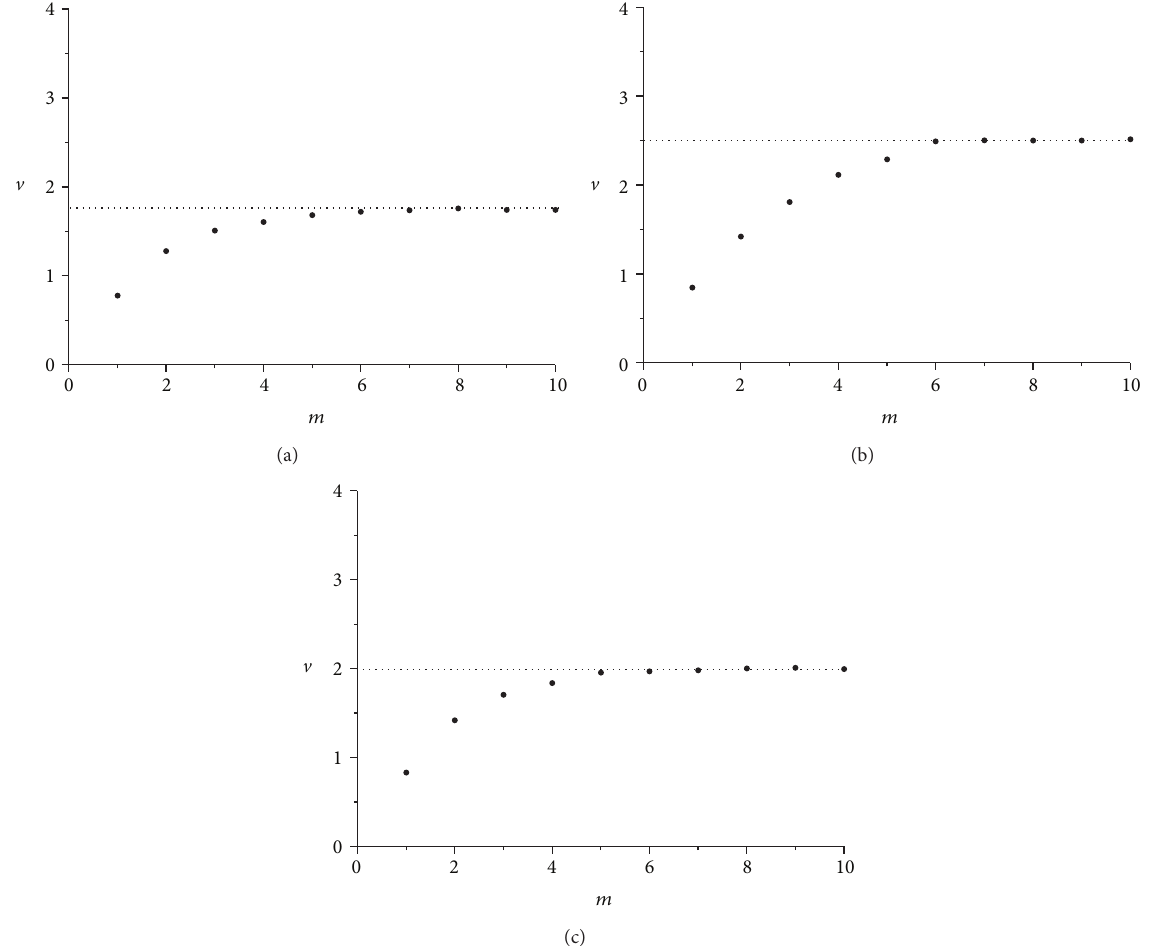
Figure 11: Correlation dimension V versus 𝑚 embedding dimension for spin rate 𝜔 1 (𝑡) time-series in the cases of (a) wax, V = 1.71 (b) gypsum, V = 2.49 , and (c) lead solder, V = 1.97 . Minimum embedding dimension is not the same in all cases, revealing the not so common dynamics of